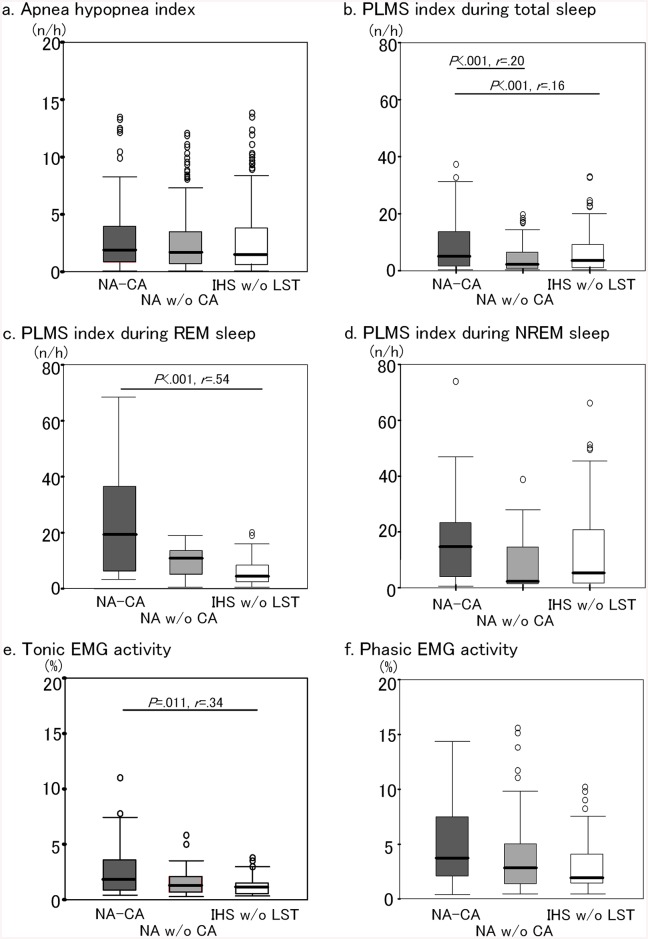
Comparisons of AHI, PLMS index and amount of RWA among the three patient groups.AHI, apnea hypopnea index; PLMS, periodic limb movements during sleep; RWA, rapid eye movement (REM) sleep without atonia; NA, narcolepsy; CA, cataplexy; IHS w/o LST, idiopathic hypersomnia without long sleep time; NREM, non-REM; EMG, electromyogram.